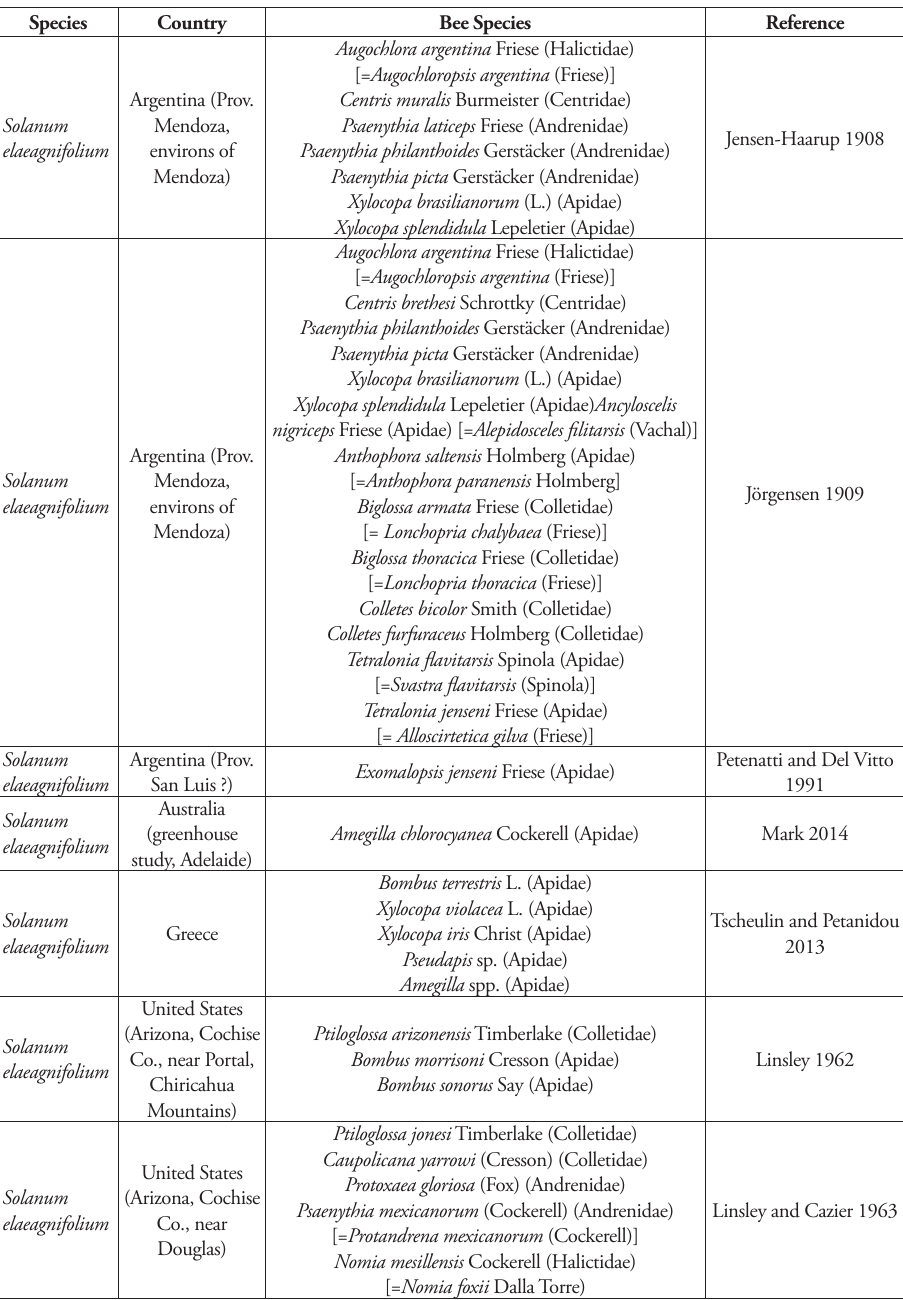
Table 2. Bee visitors recorded on members of the Elaeagnifolium clade. Scientific names of bees are as recorded in the original publications, with more recent taxonomic placements (taken from Ascher and Pickering 2017) indicated in square